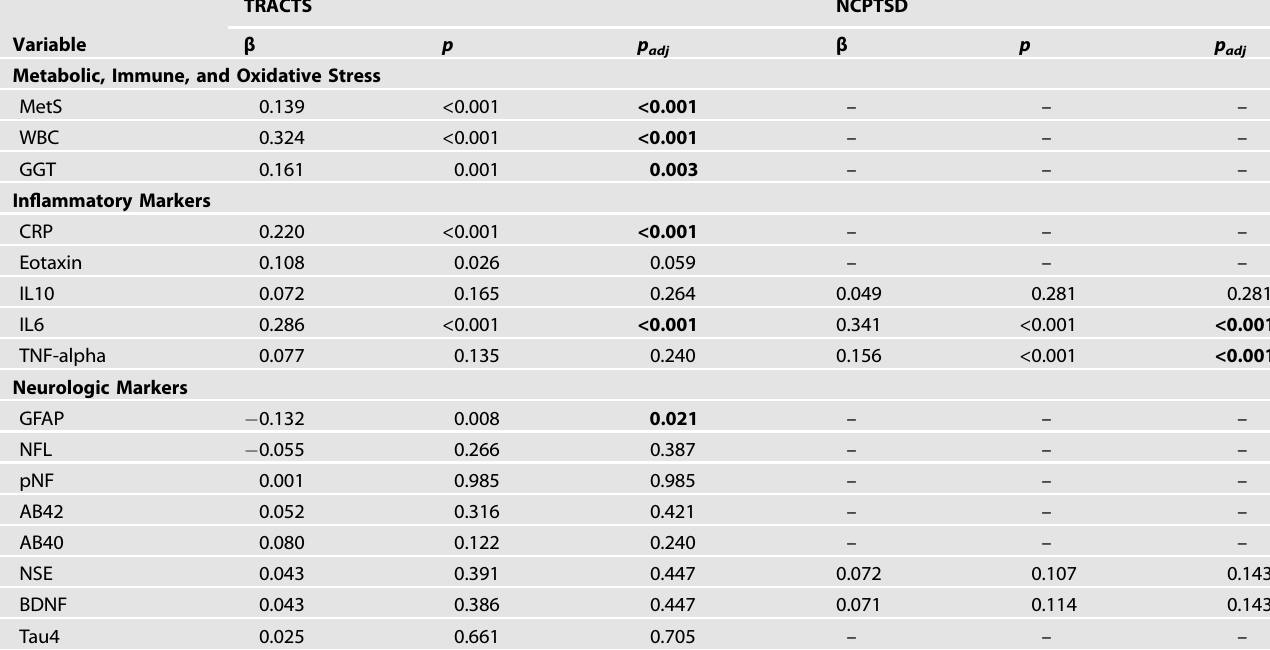
Table 4. Associations between GrimAge residuals and metabolic, immune, and neurology